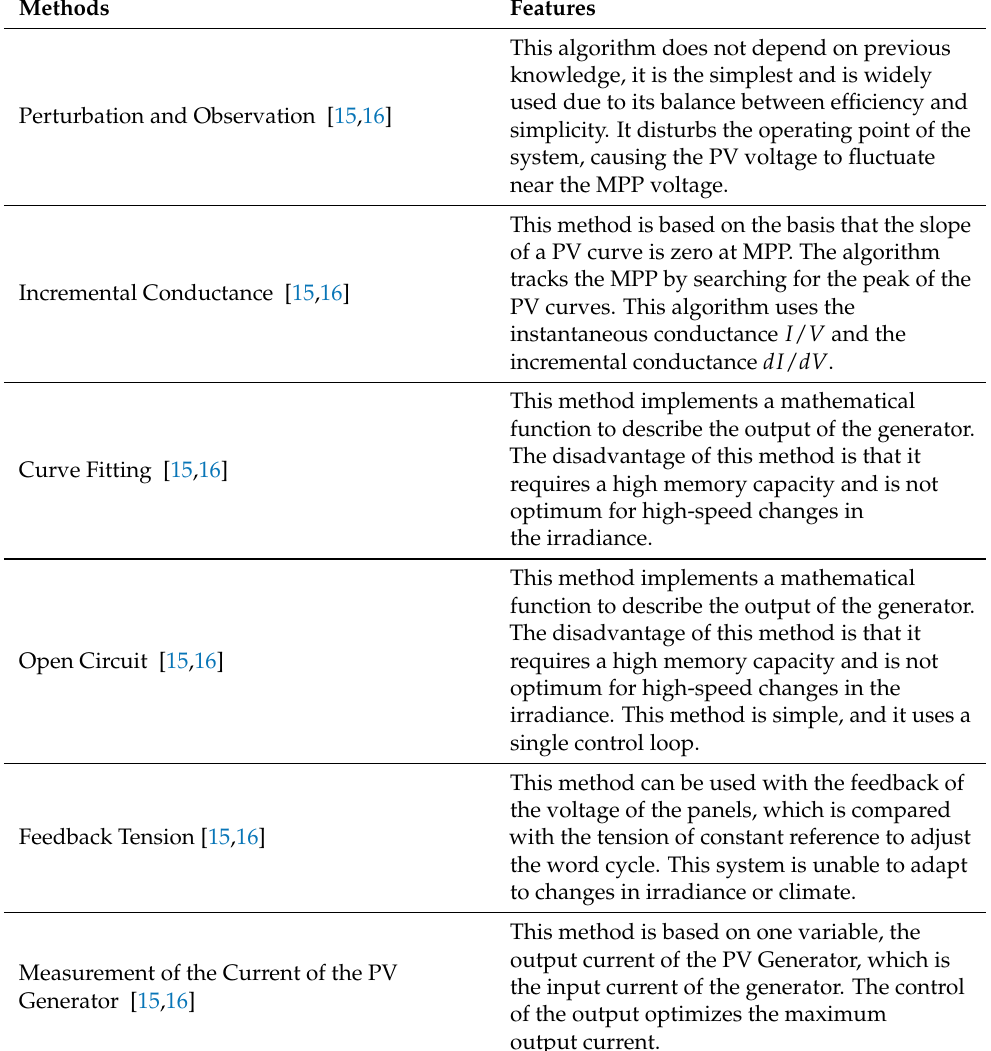
Table 1. Traditional Methods for